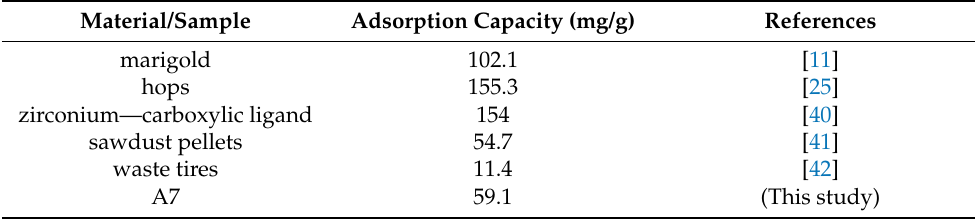
Table 4. NO 2 sorption capacity of